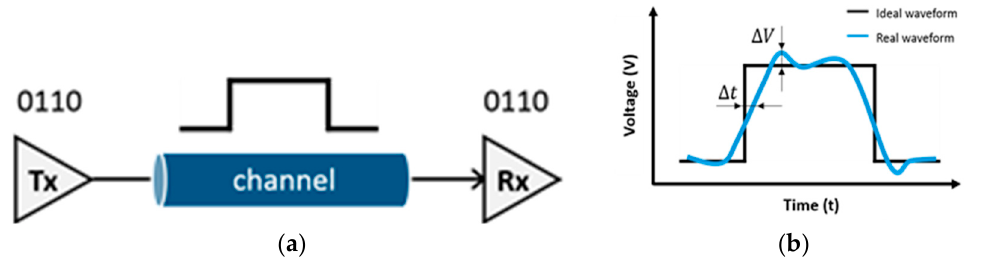
Figure 1. Digital signal transmission: ( a ) conceptual representation ( b ) ideal and real waveforms.